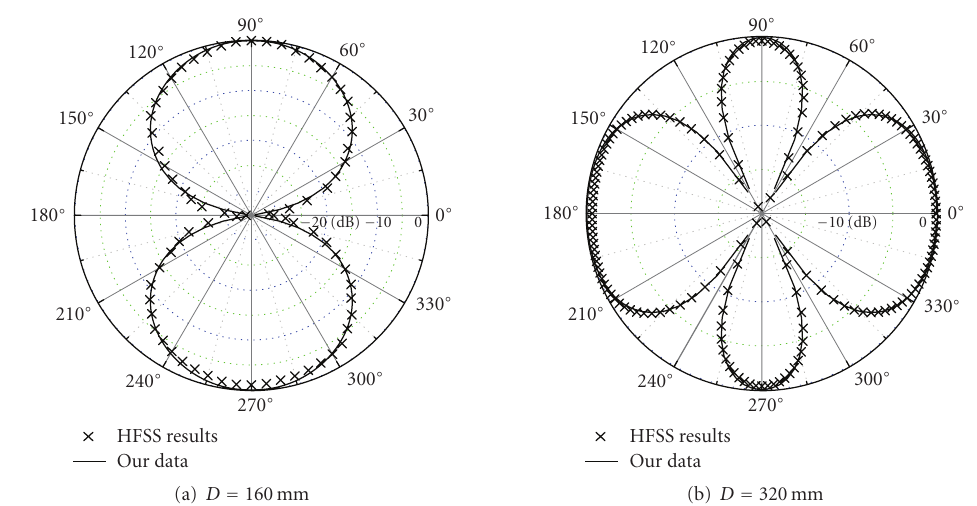
Figure 5: Comparison of our results for the two-monopole antenna’s H-plane radiation pattern with those obtained by HFSS ( f = 0 . 9375GHz, θ = 90 ◦ , V 1 = V 2 =